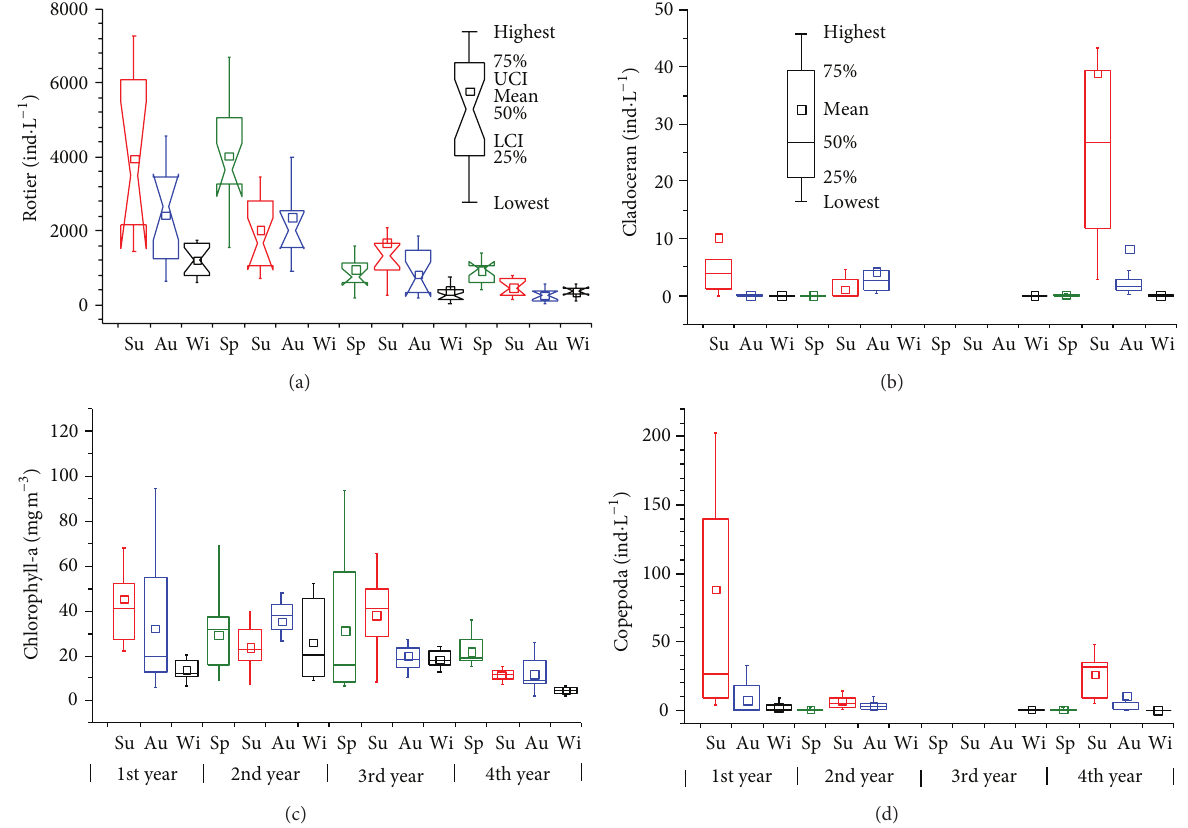
Figure 4: Seasonal variations of the total rotifer density and biotic parameters (chlorophyll a, cladoceran, and copepoda). LCI, UCI: lower and upper bound of 95% confidence interval of median, respectively. (If the notches of two box plots do not overlap, we can assume that the two median values differ at a 95% confidence level.) No data were recorded for rotifers in the 2nd winter or for crustaceans in the 3rd year.